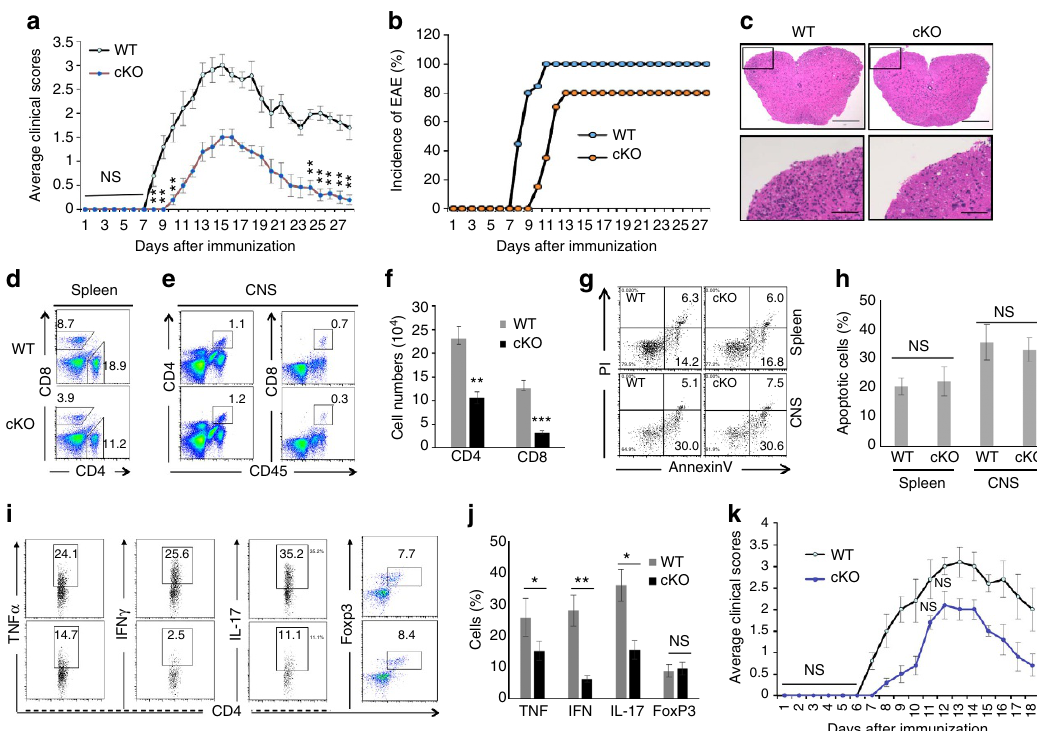
Figure 6 | EAE induction in Hrd1 cKO mice. ( a , b ) EAE was induced in 8–10-week-old WTand Hrd1 cKO mice, and the symptoms were scored daily. The average symptom scores ( a ) and disease incidence ( b ) from 15 pairs of mice are shown. ( c – j ) The spinal cords were isolated 12–15 days after EAE induction. Representative images of H&E staining are shown; scale bars, 200 m m (top); 10 m m (bottom; c ). The splenocytes ( d ) and infiltrated lymphocytes were isolated and analysed by flow cytometry for each of the indicated cell surface markers ( d , e ) and apoptosis markers ( g ). The cytokine production was determined by intracellular staining ( h , j ). Error bars represent data from five independent isolation (each purification was from spinal cords pooled from three mice; f , h , j ). ( i ) Purified naive CD4 Tcells from WTand Hrd1 cKO mice were adoptively transferred into T-cell-null mice. Two days after transfer, EAE induction was performed and the mice were scored for disease development. Error bars represent data from five pairs of recipient mice. Mann–Whitney test was used for the statistical analysis. * P o 0.05, ** P o 0.01 and *** P o 0.001. The P value is o 0.05 in ( a , k ) at each scored time point unless specifically